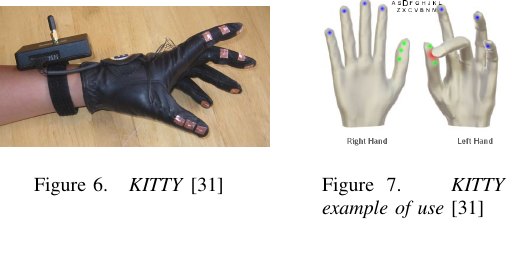
Figure 6. KITTY [31] Figure 7. KITTY example of use [31]